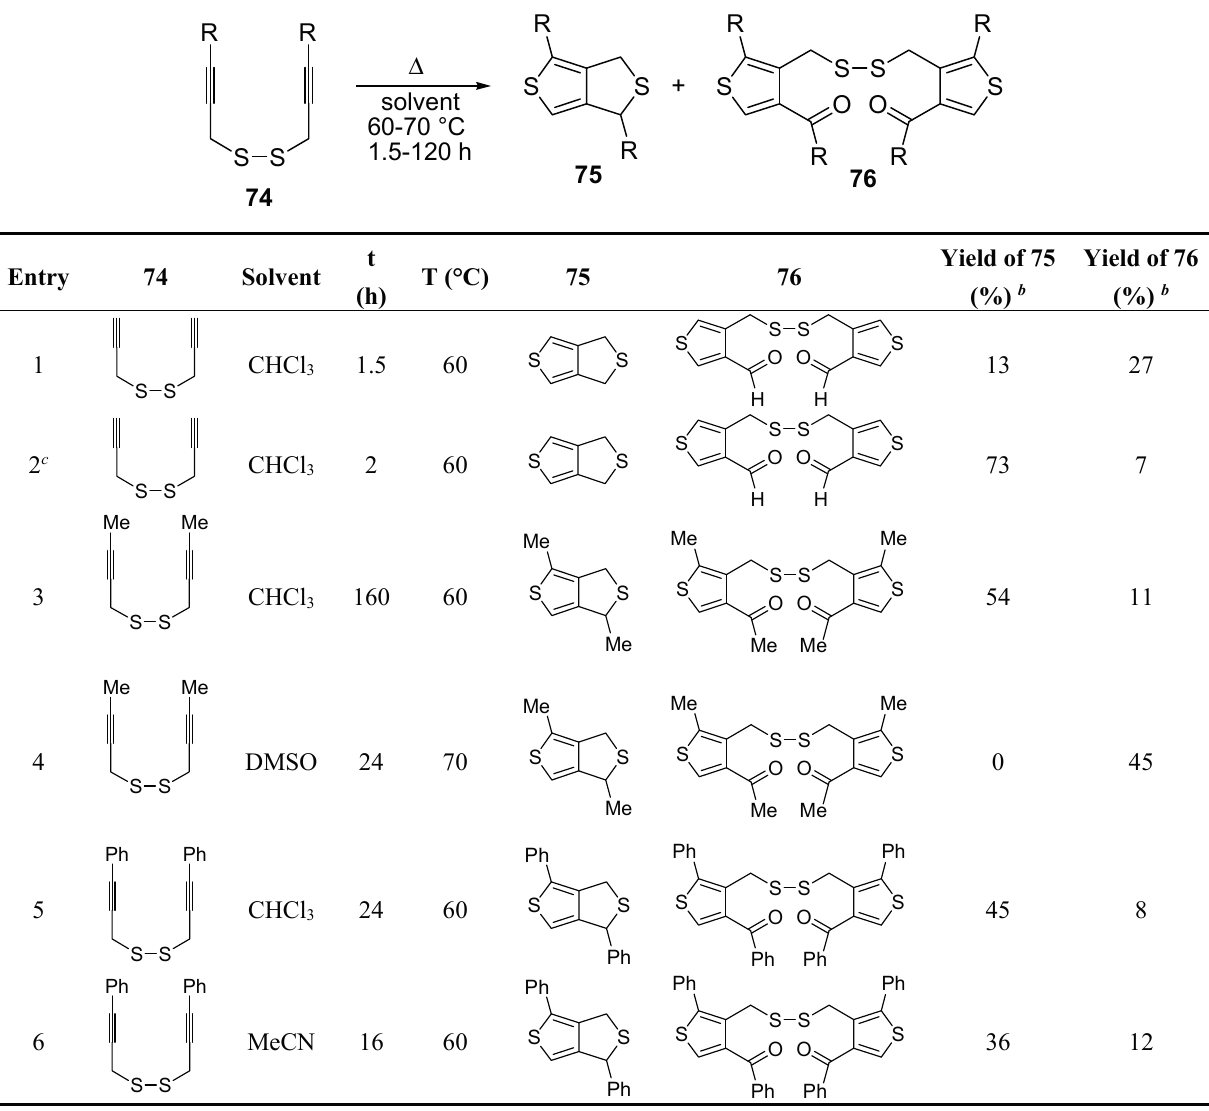
Table 7. Synthesis of 1,3-dihydrothieno[3,4- c ]thiophenes 75 and thienyl disulfides 76